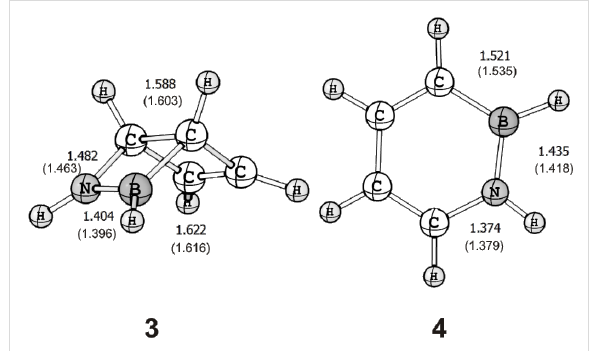
Figure 1: Geometries of 3 and 4 computed at the CCSD(T)/TZ2P and CASSCF(6,6)/6-31G* (in parentheses) levels of theory. Bond lengths are given in angstroms (Å).